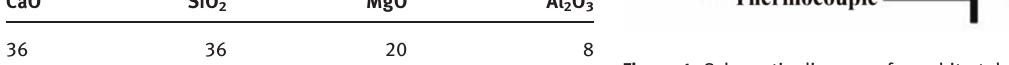
Figure 1: Schematic diagram of graphite tube resistance